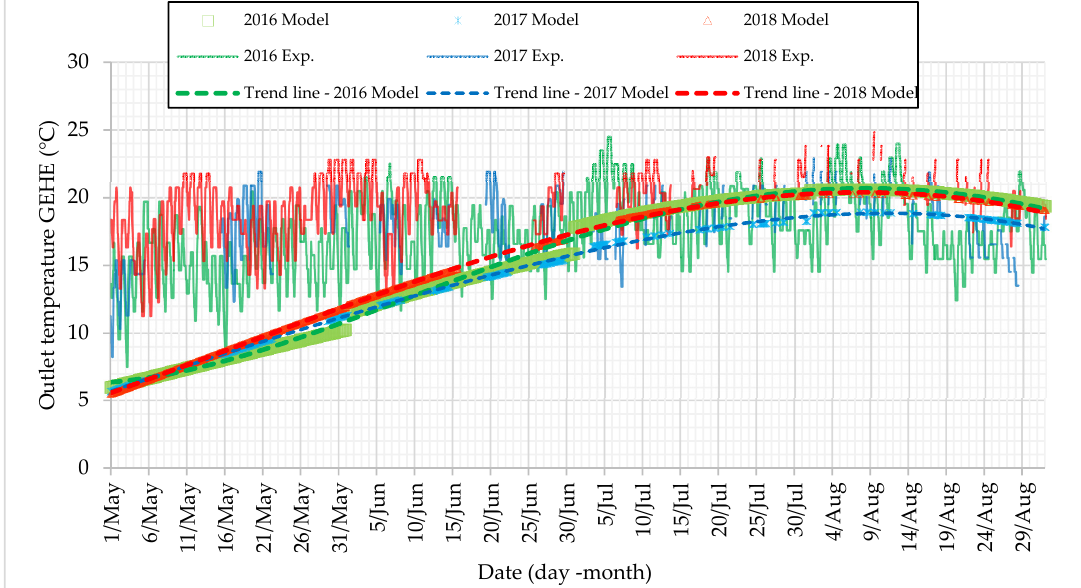
Figure 4. Temperature distribution at the GAHE outlet relative to the modeled temperatures.